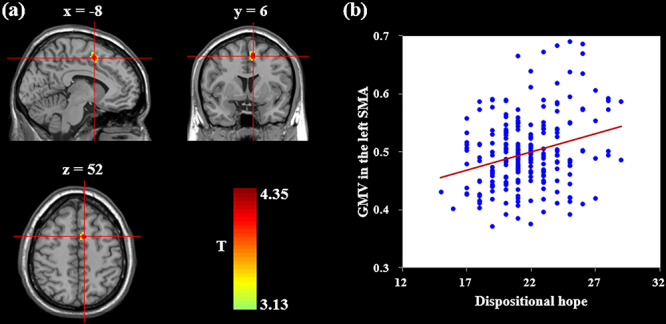
Regional GMV linked to dispositional hope. (a) Brain image showing that dispositional hope is positively correlated with GMV in the left SMA after controlling for sex, age, family SES and total GMV. (b) Scatter plots depicting the correlation between dispositional hope and left SMA volume (r = 0.28, P < 0.001). The background image was a specific study template in the MNI152 space (i.e. the Ch2 template in the REST slice viewer), to which each participant’s gray matter image was normalized.